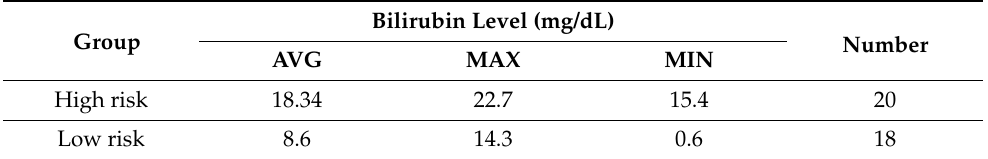
Table 1. The distribution of bilirubin levels and the number of group samples for high risk and low risk